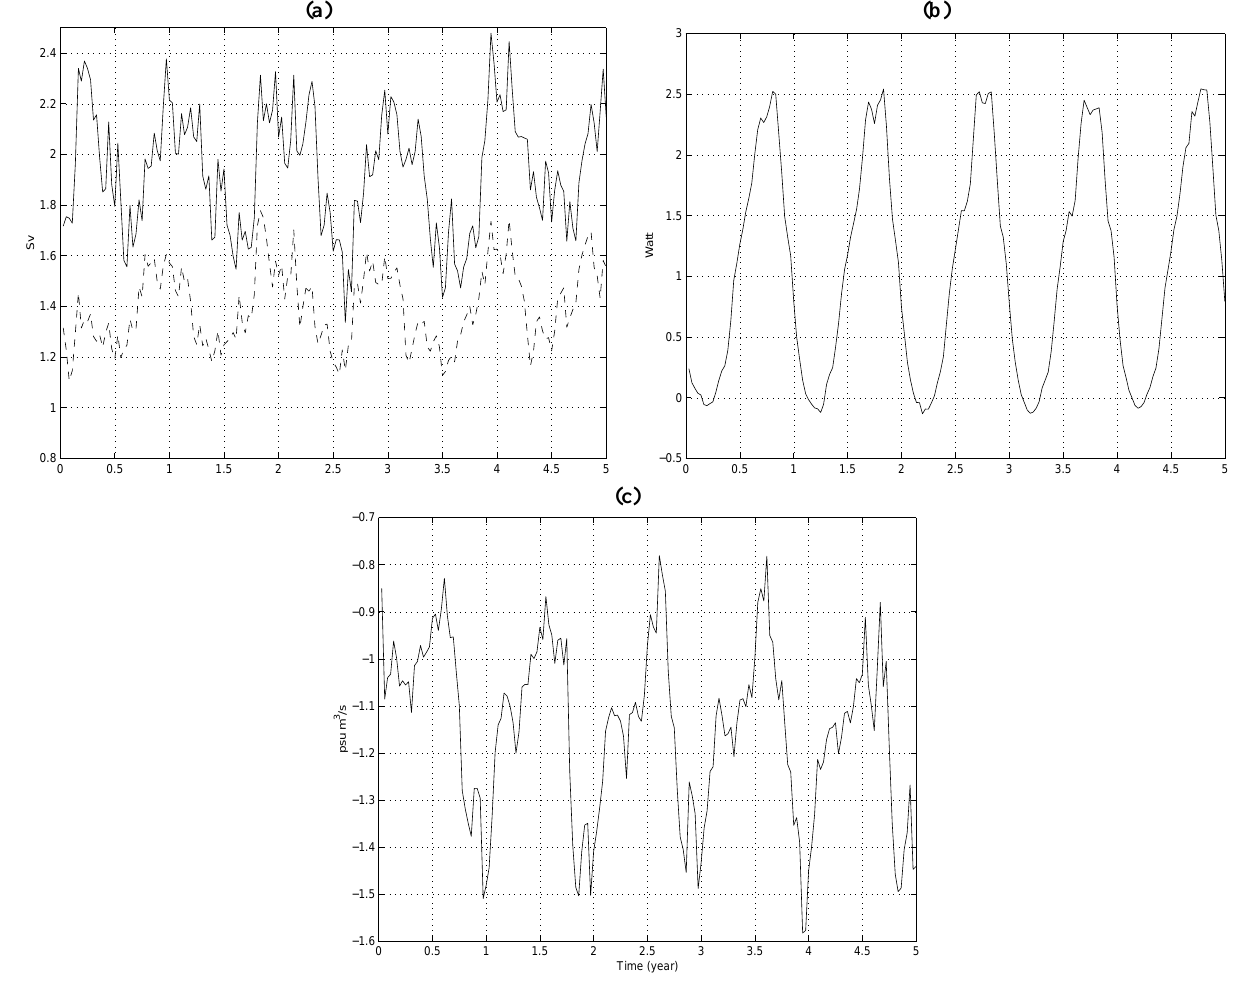
Fig. 20. The time series of mass, heat and salt transports at the Strait of Sicily for the 5-year model integration. Positive values indicate an eastward transport. Panel a : Total and baroclinic (dashed line) volume transports. Units are Sverdrup (10 6 m 3 /s). Panel b : Net heat transport. Units are Watts × 10 13 . Panel c : Net salt transport. Units are psu · m 3 /s × 10 6